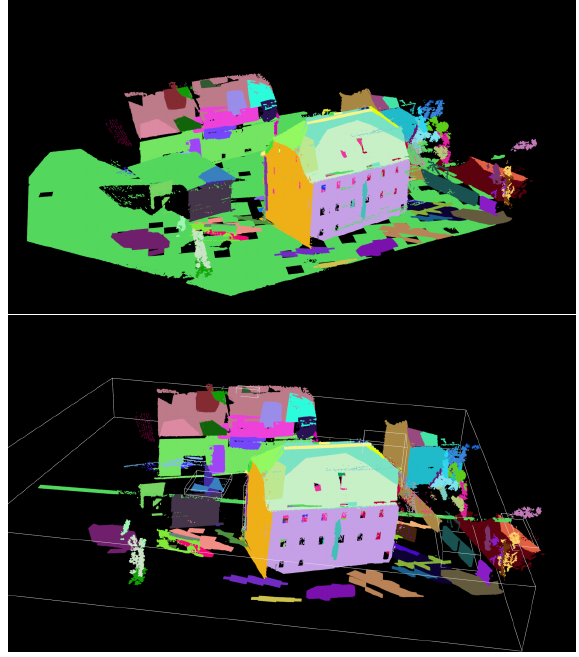
Figure 4. Segmented planes of the test scene with a building with its